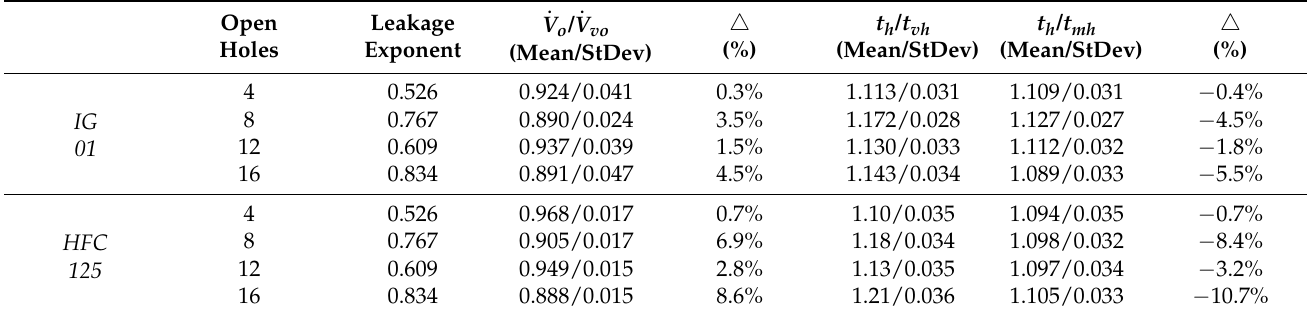
Table 3. Summary of theoretically predicted and experimentally observed